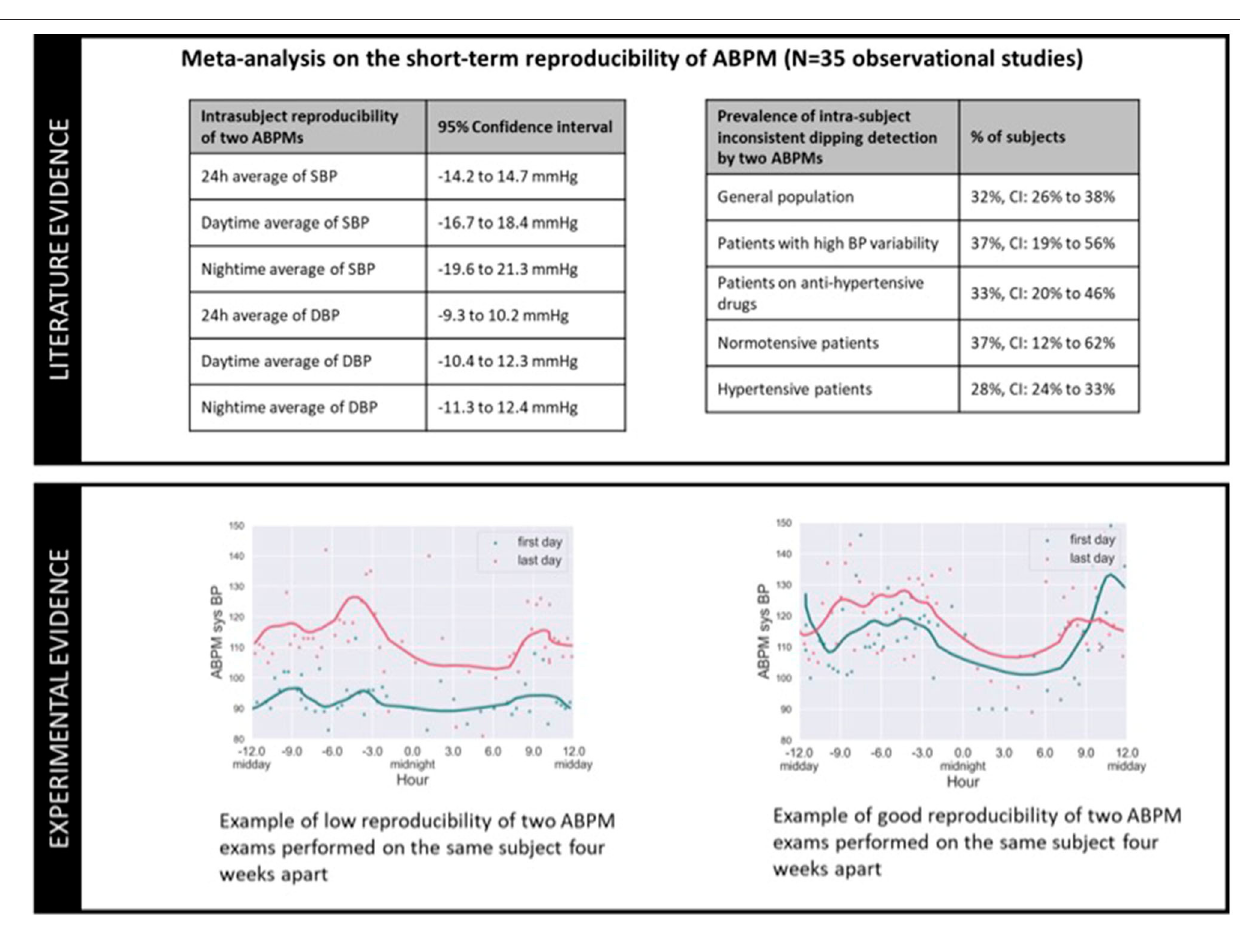
and period of ABPM measurements (e.g., once every 20 min) differs from that of most continual cuffless BP monitors